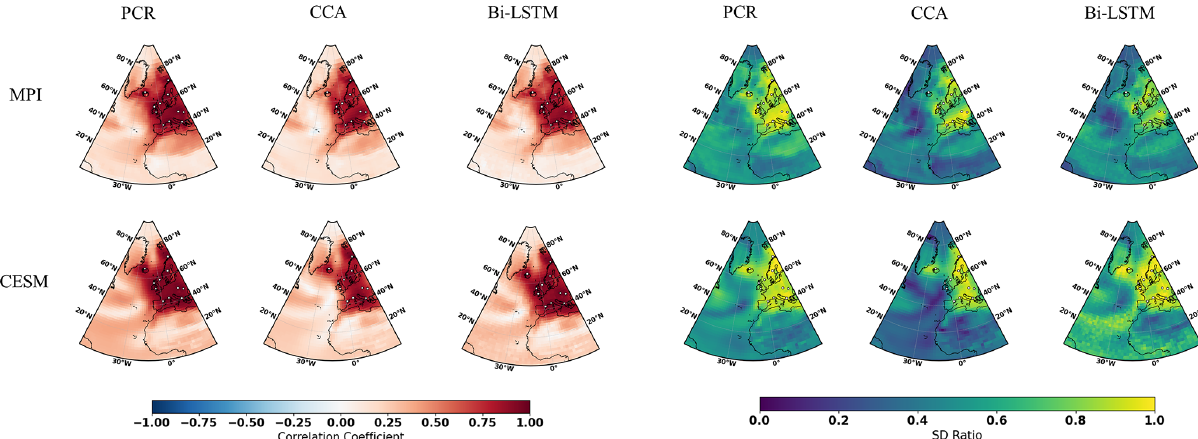
Figure 2. NAE reconstruction results of CFR methods (including PCR, CCA, and Bi-LTSM) using MPI and CESM numerical simulations as the target temperature field. All of the CFR methods employ the same proxy network with a full set of 11 ideal pseudoproxies that span the same reconstruction period from 850 to 1899CE. The employed pseudoproxy geolocations are shown as white circles in all panels. CC is correlation coefficient, and SD represents standard deviation.